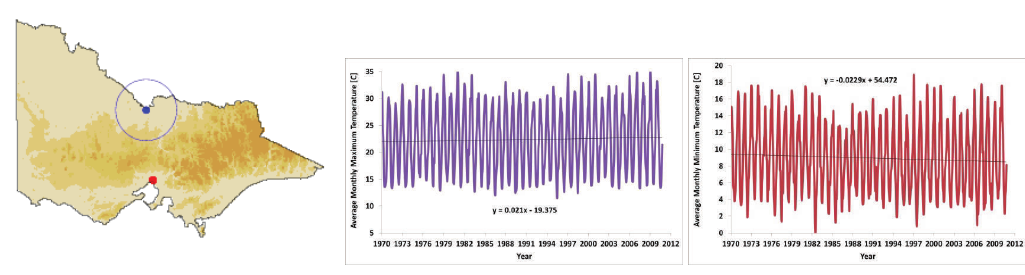
Figure 3. Last four decades raw data for monthly mean maximum and minimum temperatures for selected historical measuring stations in Victoria,